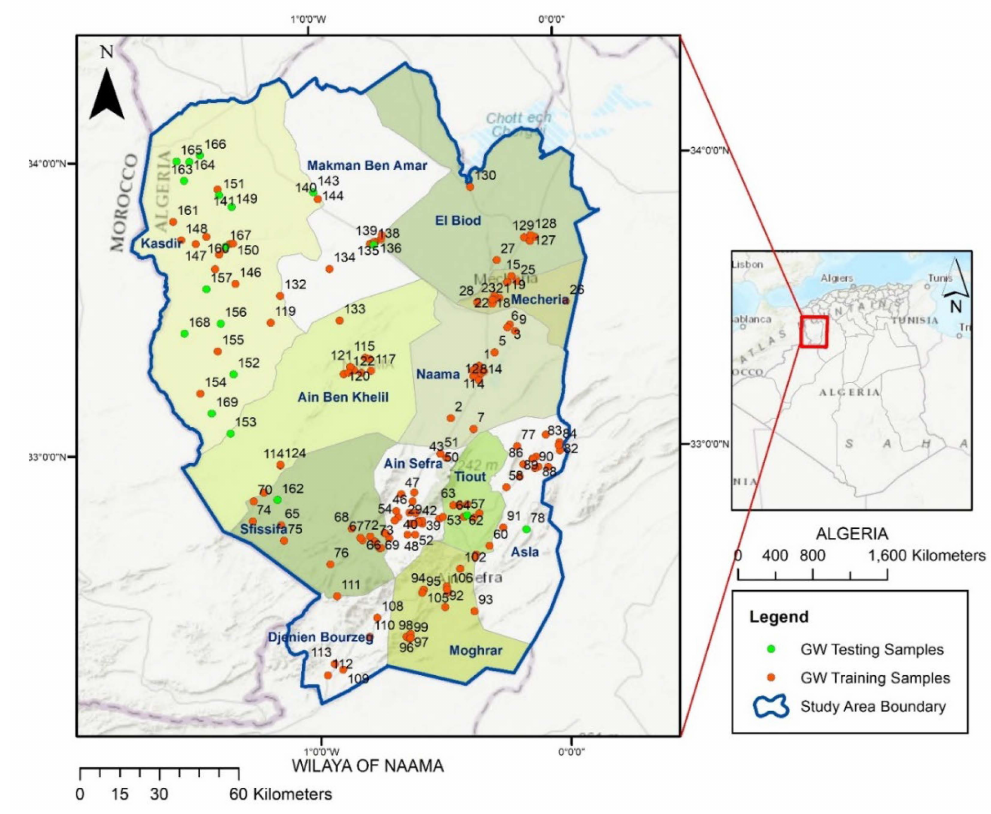
Figure 1. Localization of the study area and sampling